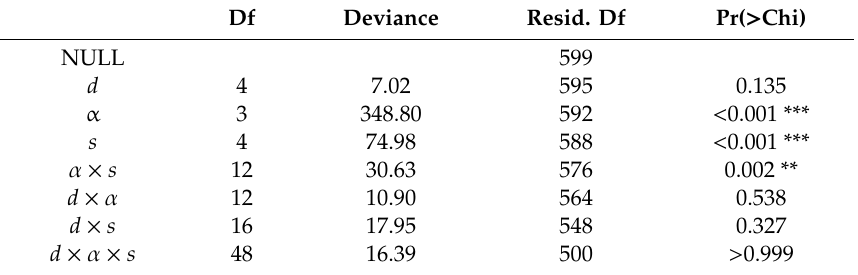
Table 2. Results of logistic regression of camera-tree distance ( d ), angular displacement ( α ) and species identity ( s ) on 3-D model reconstruction.